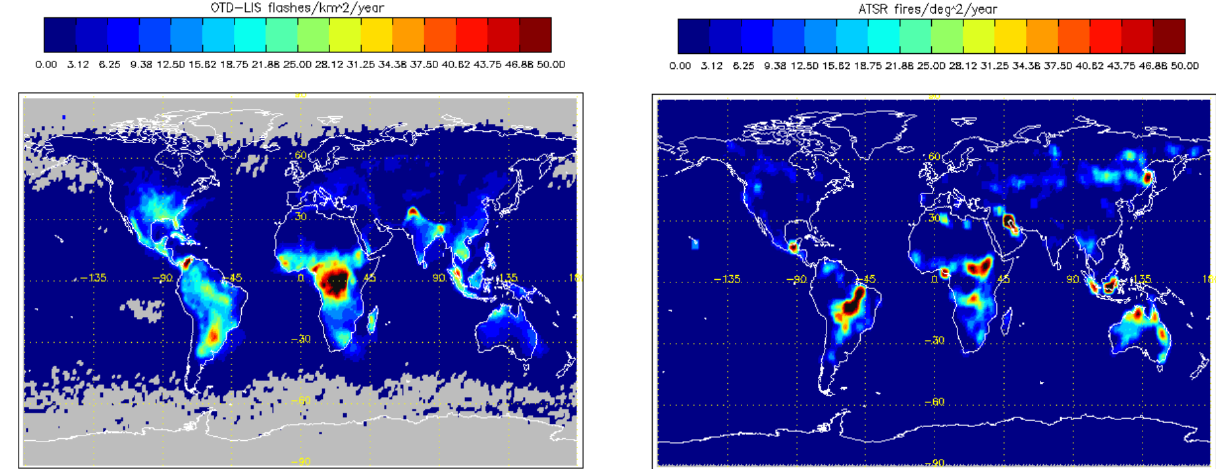
Figure 6. Interpretation aids for process attribution: mean flash rate climatology (1998–2010) from the LIS-OTD sensor (left; Cecil et al., 2014) and fire count climatology (1997–2003) from the ATSR sensor (right; Arino et al.,